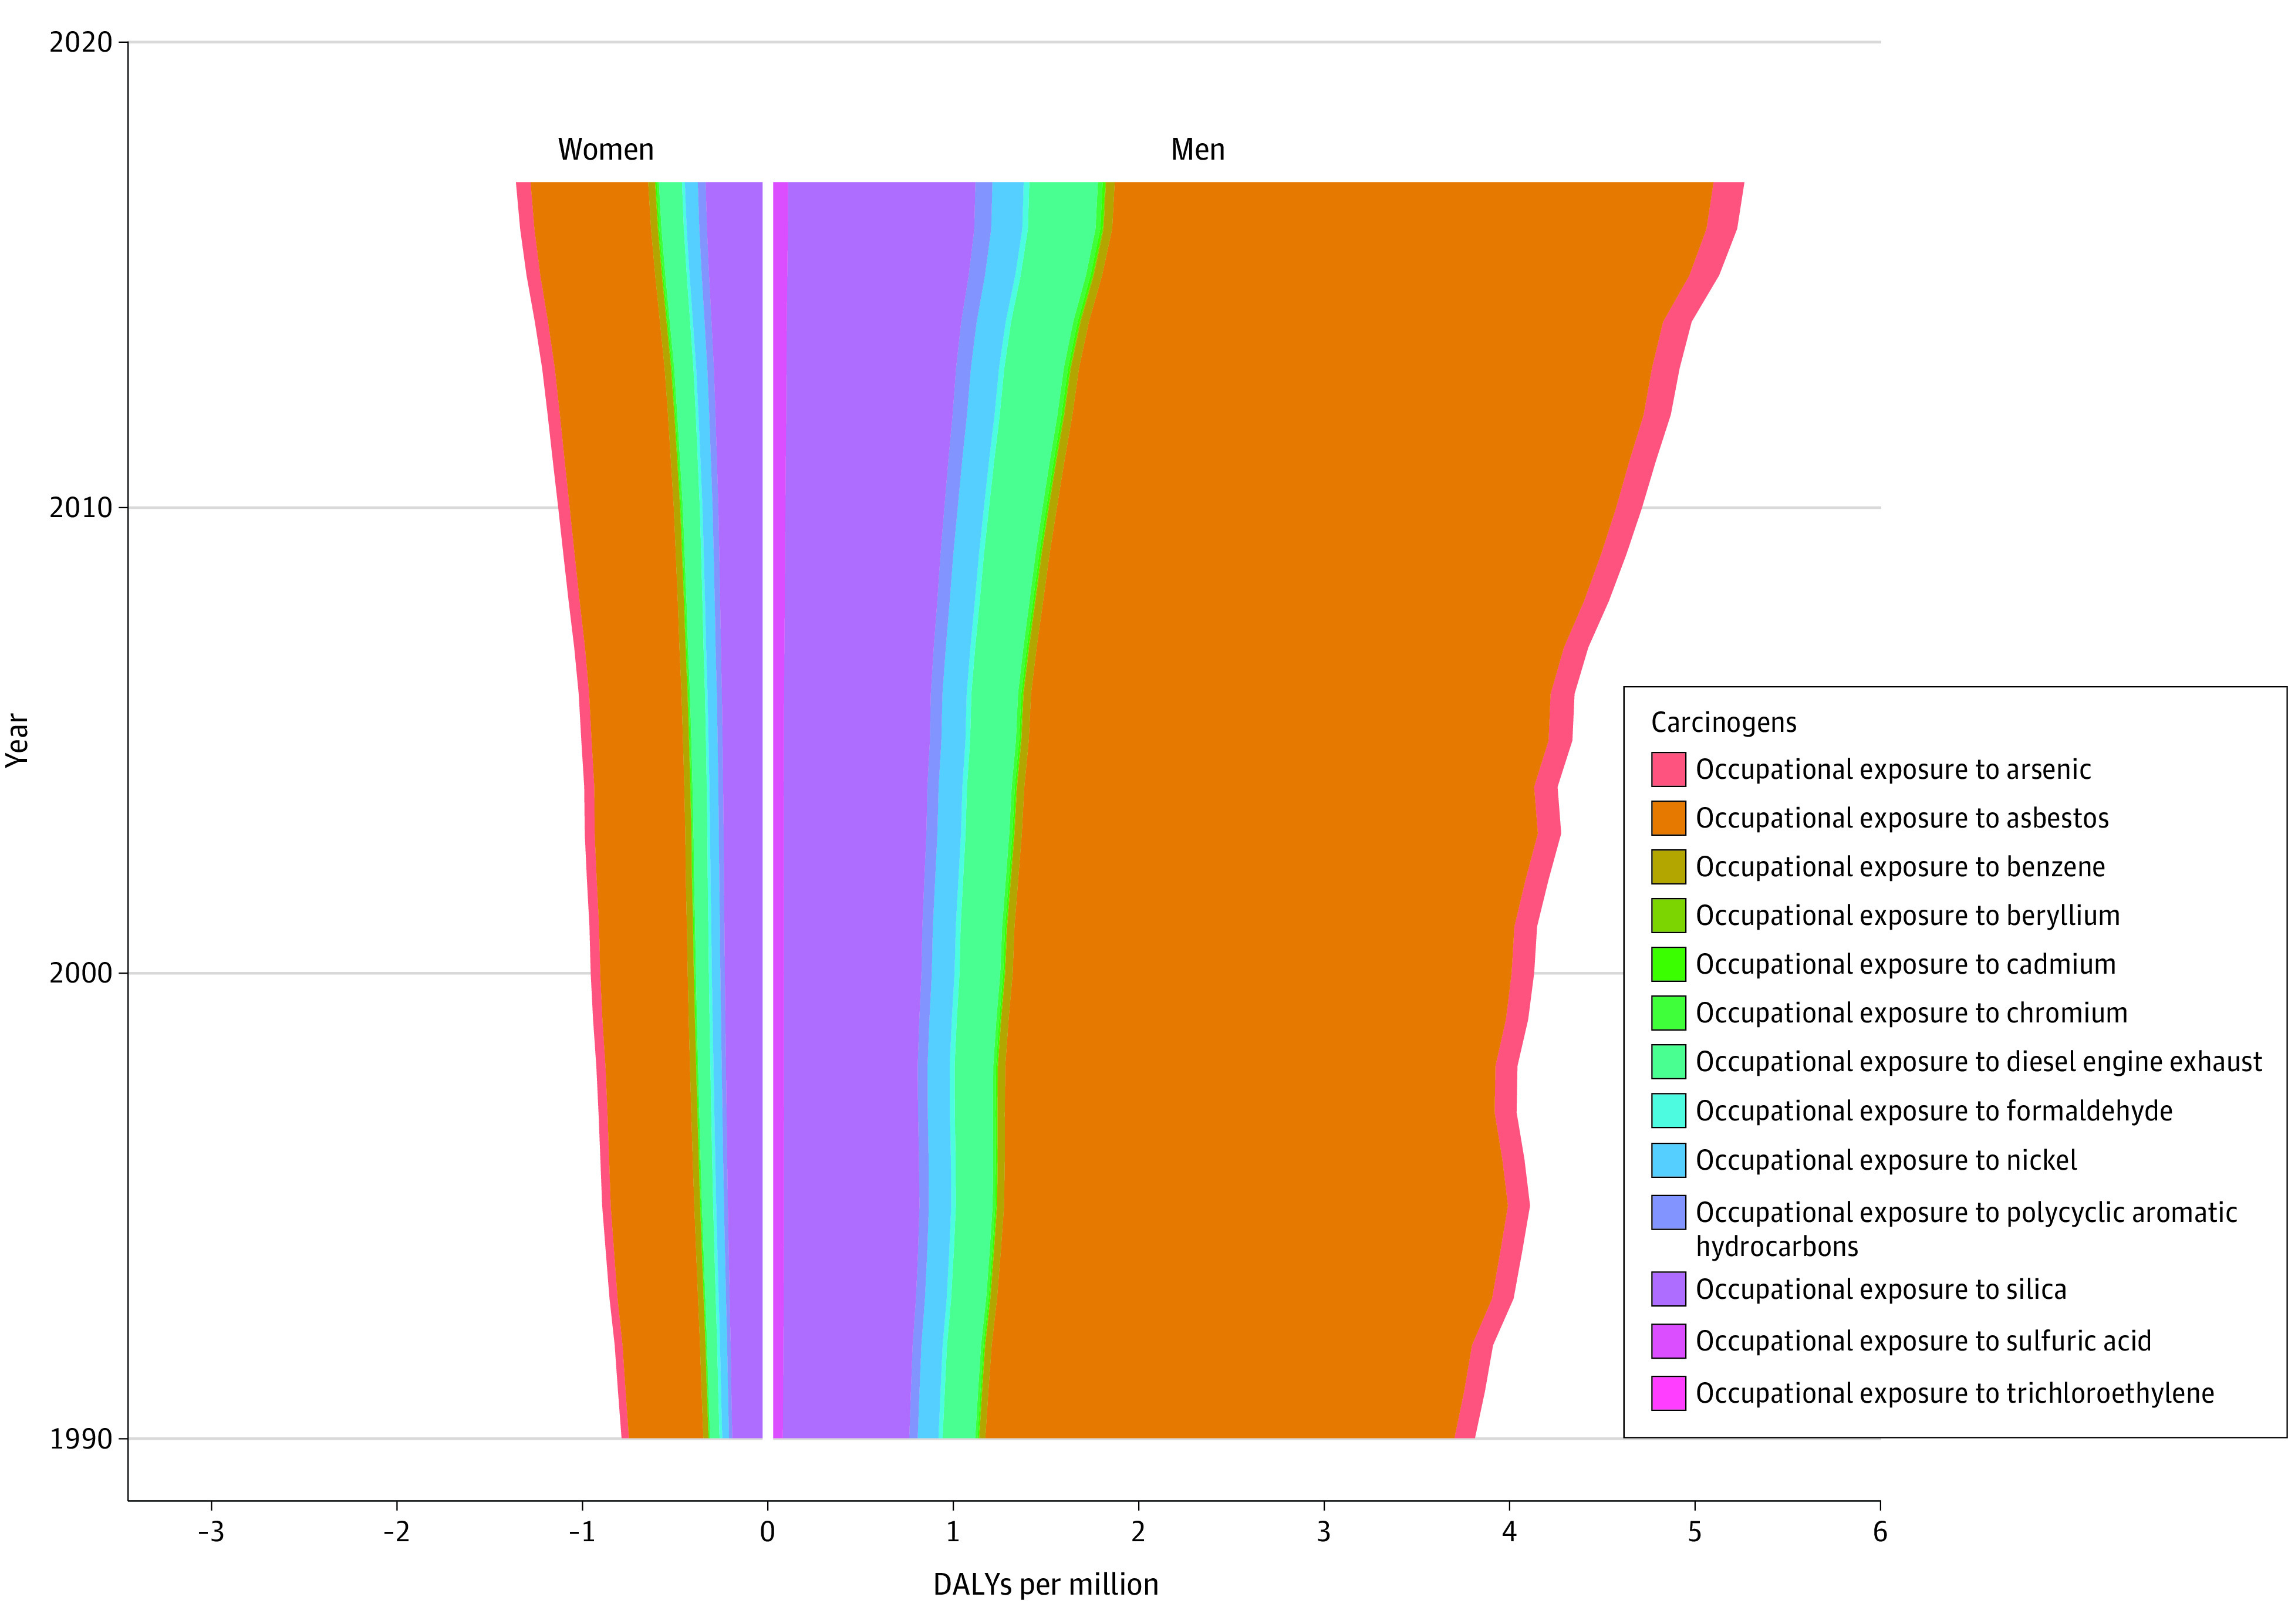
Comparison of Changes in Number of Attributable Cancer Disability-Adjusted Life-Years (DALYs) From 1990 to 2017 for Each of the 13 Occupational Carcinogens Between Men and Women